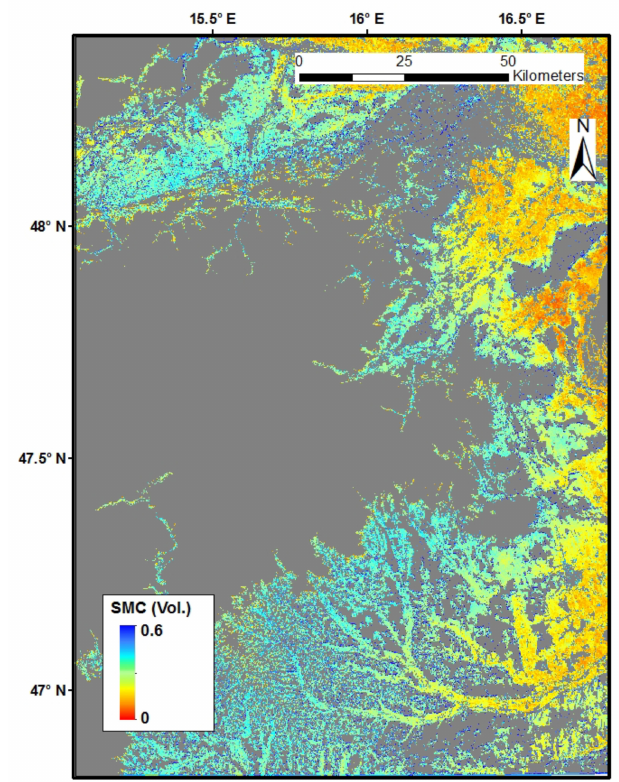
Figure 9. Volumetric SMC mapping of the study